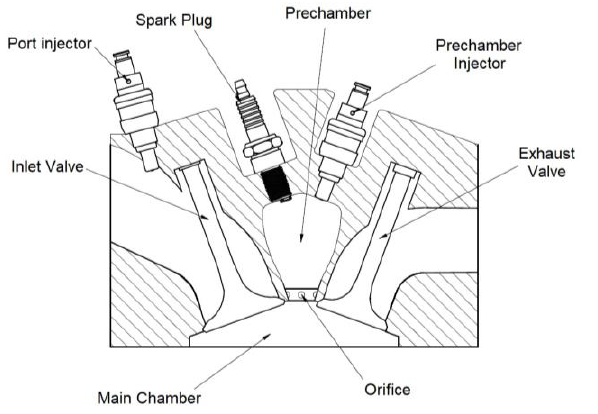
Fig. 7. Simplified scheme of hydrogen combustion prechamber